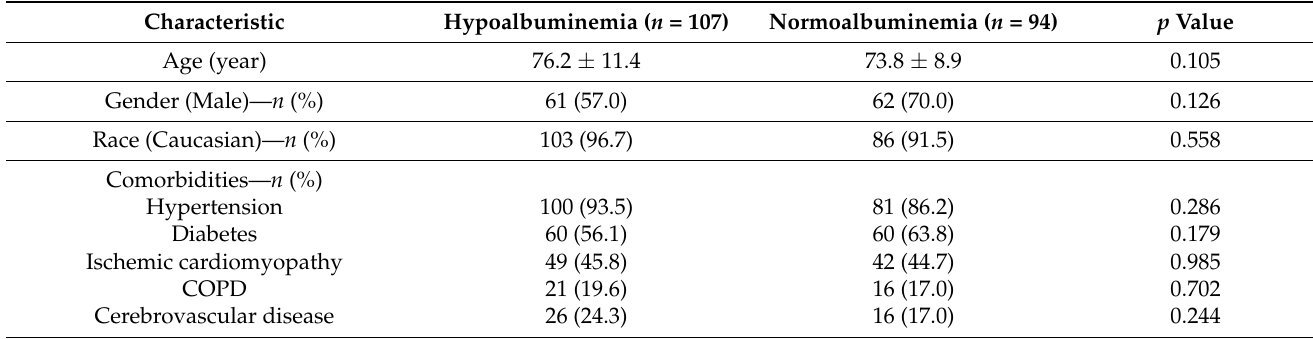
Table 2. Patient characteristics according to